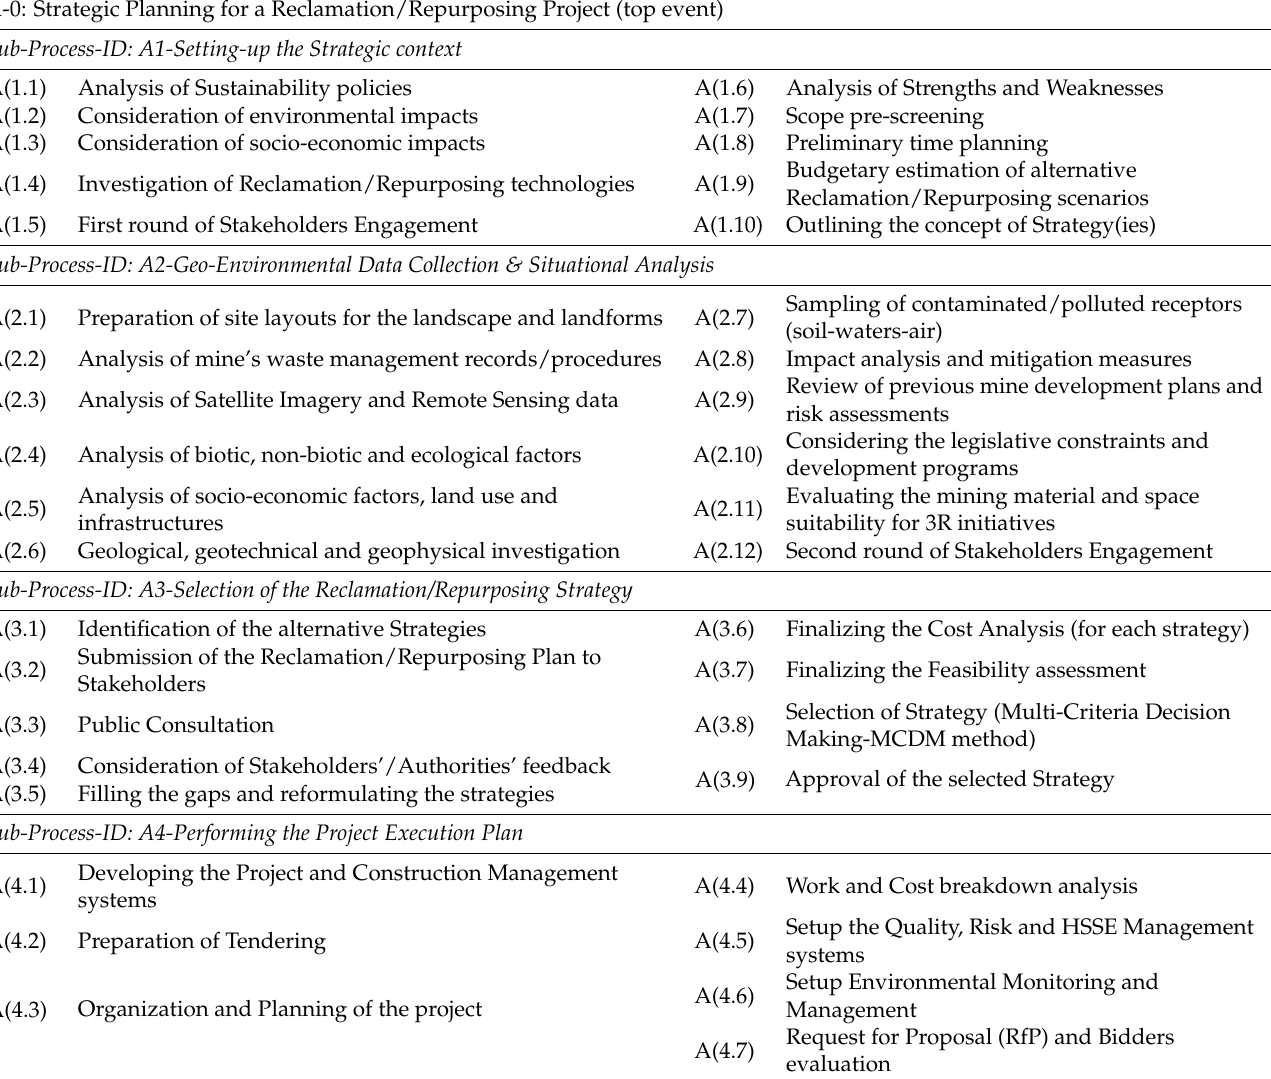
Table 1. Description of Processes /Activities.